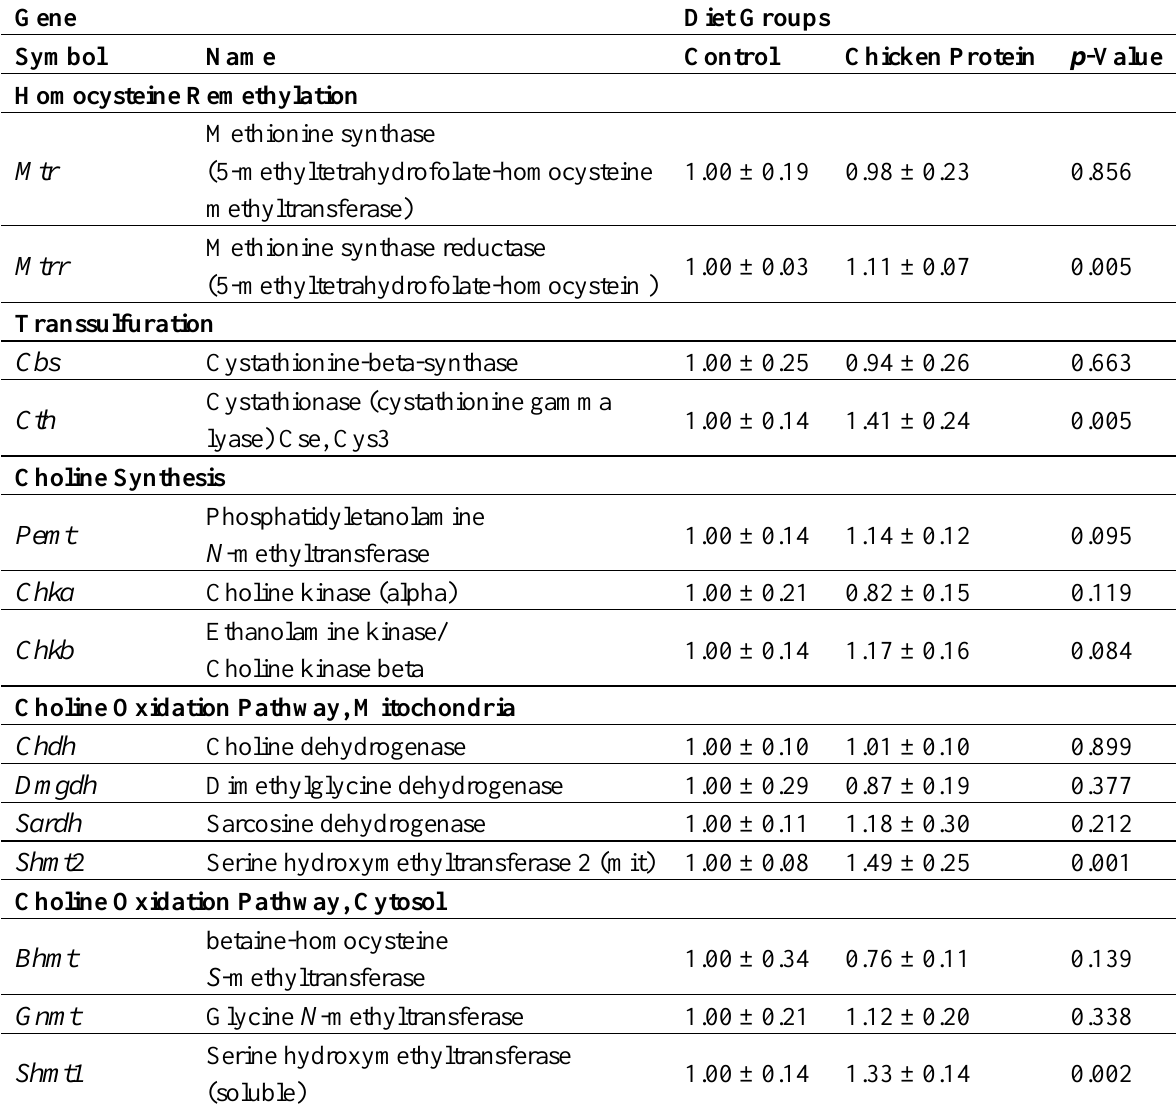
Table 2. Hepatic gene expression after 4 weeks of dietary intervention 1